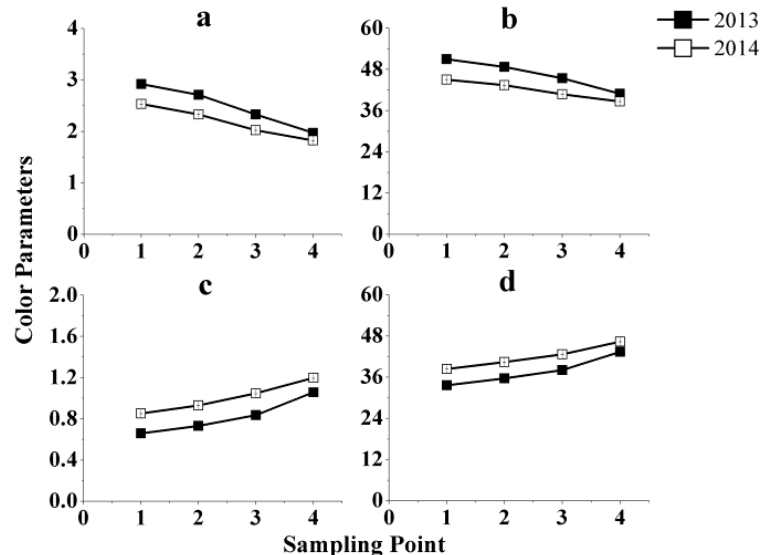
Figure 3. Chromatic evolution during vinification of Beibinghong red icewine from two vintages, 2013 and 2014. ( a ) Evolution of color intensity during vinification; ( b ) Evolution of red % during vinification; ( c ) Evolution of hue during vinification; ( d ) Evolution of yellow % during vinification.